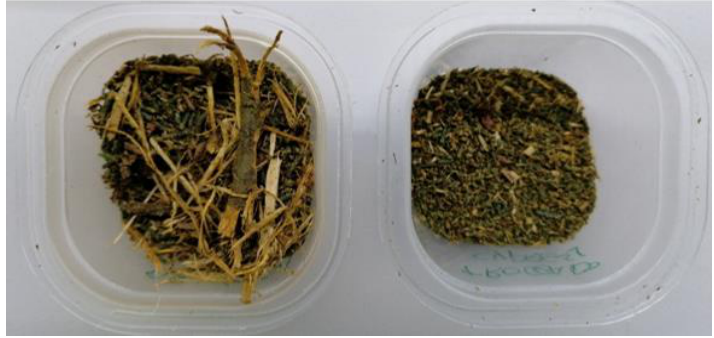
Figure 1. Cypress biomass before ( left ) and after ( right ) being chopped.